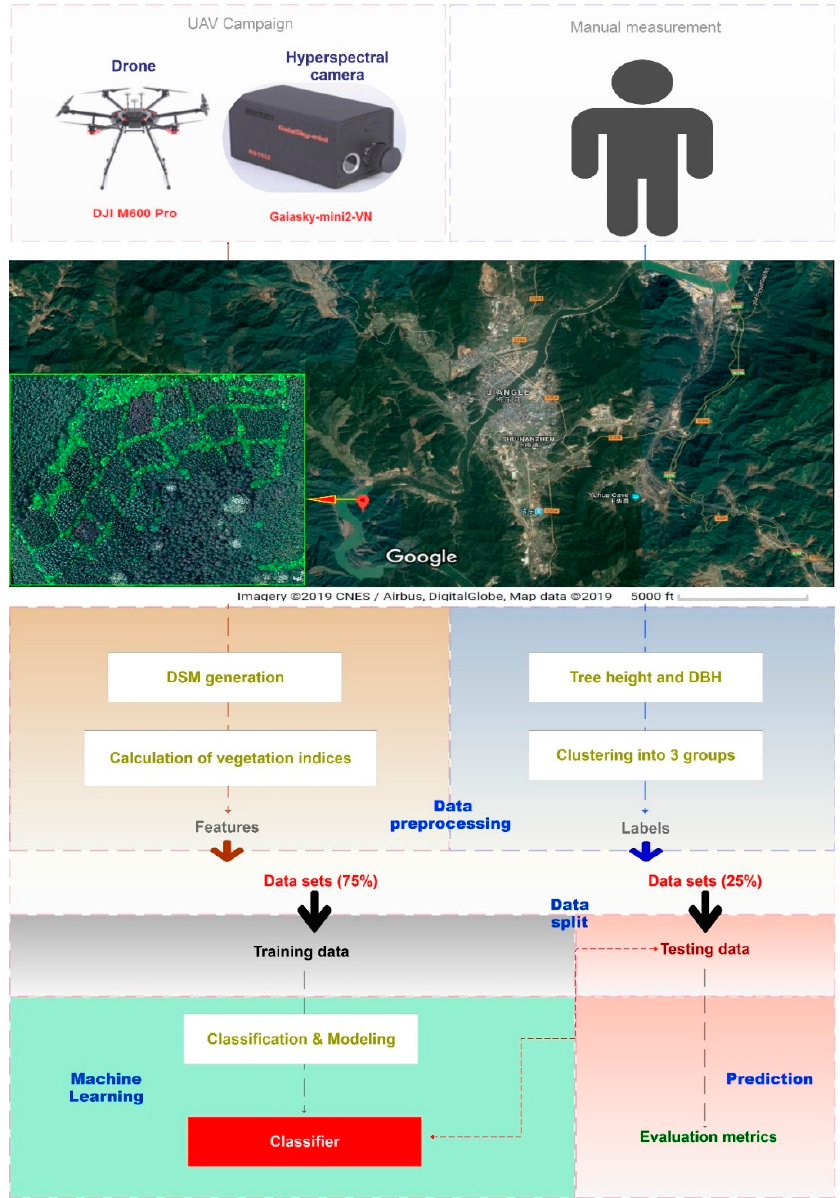
Figure 1. Pipeline process for screening fast growing Chinese fir.